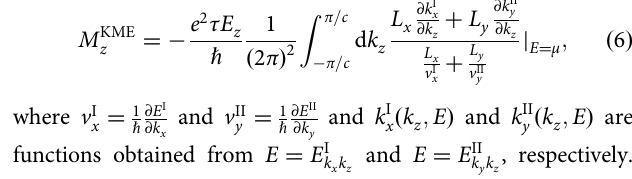
Fig. 3 One-dimensional prism of a Chern insulator. a Schematic fi gure of the one-dimensional prism of a Chern insulator, extended along z -axis, with its size L x × L y within the xy plane. We call the four side surfaces I, II, III and IV. b The schematic fi gure for current conservation at the corners around the one-dimensional prism in a . Here, j I x and j II y are current densities in the circumferential direction of the prism on the surfaces I and II, respectively, and we impose them to be equal. v I x and v II y are corresponding velocities of electrons, and u I xz and u II yz are amplitudes of the wavefunctions in the respective